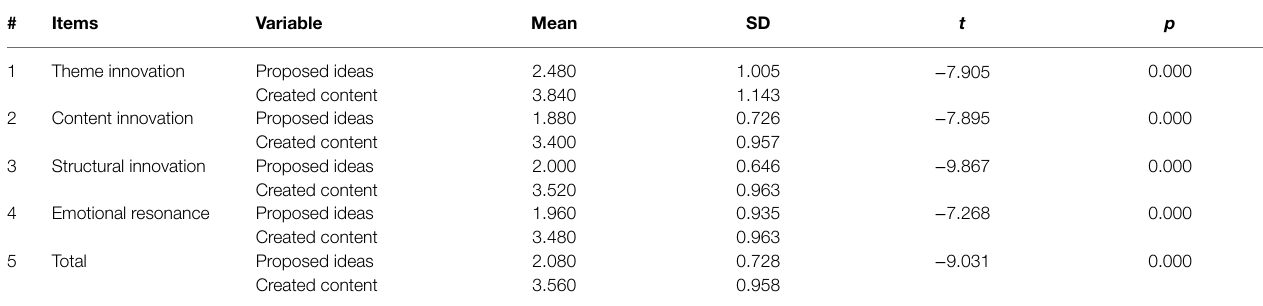
TABLE 9 | Changes in innovation: evaluation of proposed ideas and created content and their